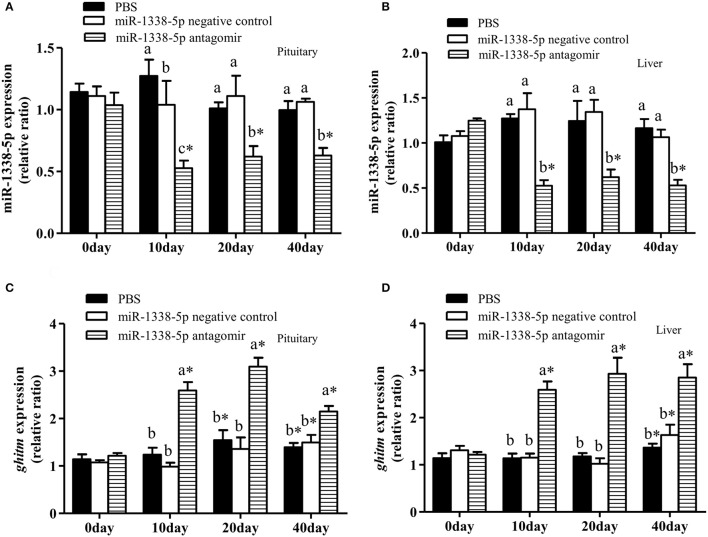
Effect of inhibiting miR-1338-5p on the expression of miR-1338-5p and ghitm in pituitary and liver of GIFT over 40 days time period. Juvenile GIFT weighing about 5.8 g received a tail-vein injection of PBS, miR-1338-5p negative control, or miR-1338-5p antagomir at a dose of 50 mg kg−1 body weight. The antagomir was injected once every 6 days. qRT-PCR analysis was used to detect the relative expression of miR-1338-5p (A,B) and ghitm
(C,D) (n = 9–12 fish per group). The GIFT injected with PBS were taken as the control. *P < 0.05 indicates significant differences between values of each treatment obtained before and after injection by paired-samples t-test. Diverse lowercase letters show significant differences (P < 0.05) in different treatments of each sampling point by Duncan′s multiple range test. Fold changes in expression levels were normalized against the pre-treatment sampling point of PBS group.